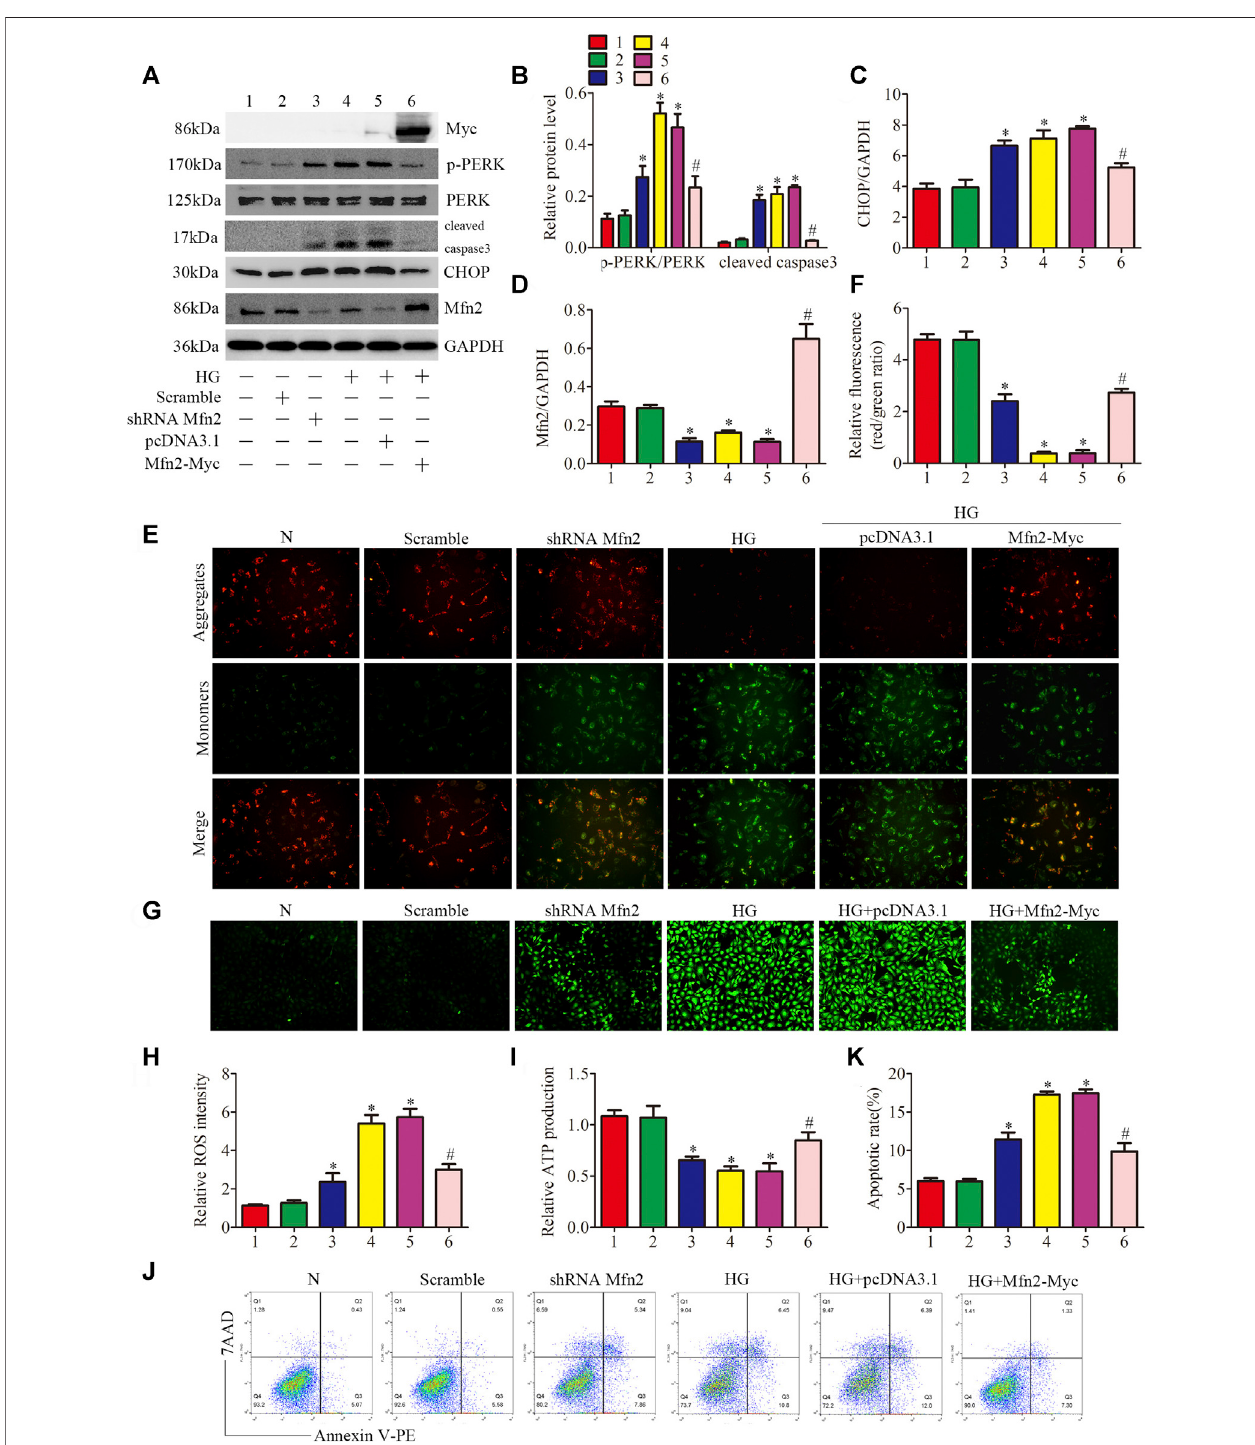
FIGURE 7 | Role of Mfn2 in PERK signaling pathway related-mitochondrial dysfunction, MAMs reduction and apoptosis. (A – D) Representative Western blots of Myc-tag,p-PERK,PERK,cleavedcaspase3,CHOP,Mfn2expressionandquantitationpergroup(n (cid:1) 3). (E,F) RepresentativeimagesofMMPinculturedpodocytesby JC-1 stainingandquanti fi cation pergroup(n (cid:1) 3)(originalmagni fi cation, × 200). (G,H) RepresentativeimagesofDCFH-DA fl uorescence(green)incultured podocytesto assessROSproductionandquanti fi cationpergroup(n (cid:1) 3)(originalmagni fi cation, × 100). (I) ATPproductionwasassessedandquanti fi cationpergroup(n (cid:1) 3). (J, K) Flow cytometry analysis of apoptosis in cultured podocytes and quantitation per group (n (cid:1) 3). 1, 2, 3, 4, 5, 6 represent N, Scramble, shRNA Mfn2, HG, HG + pcDNA3.1, HG + Mfn2-Myc, respectively; N (cid:1) 5 mM glucose for 24 h; HG (cid:1) 25 mM glucose for 24 h; Scramble (cid:1) shRNA-scrambles; shRNA (cid:1) short hairpin RNA; * p < 0.05 compared with podocytes cultured in normal conditions; # p < 0.05 compared with podocytes treated with HG.